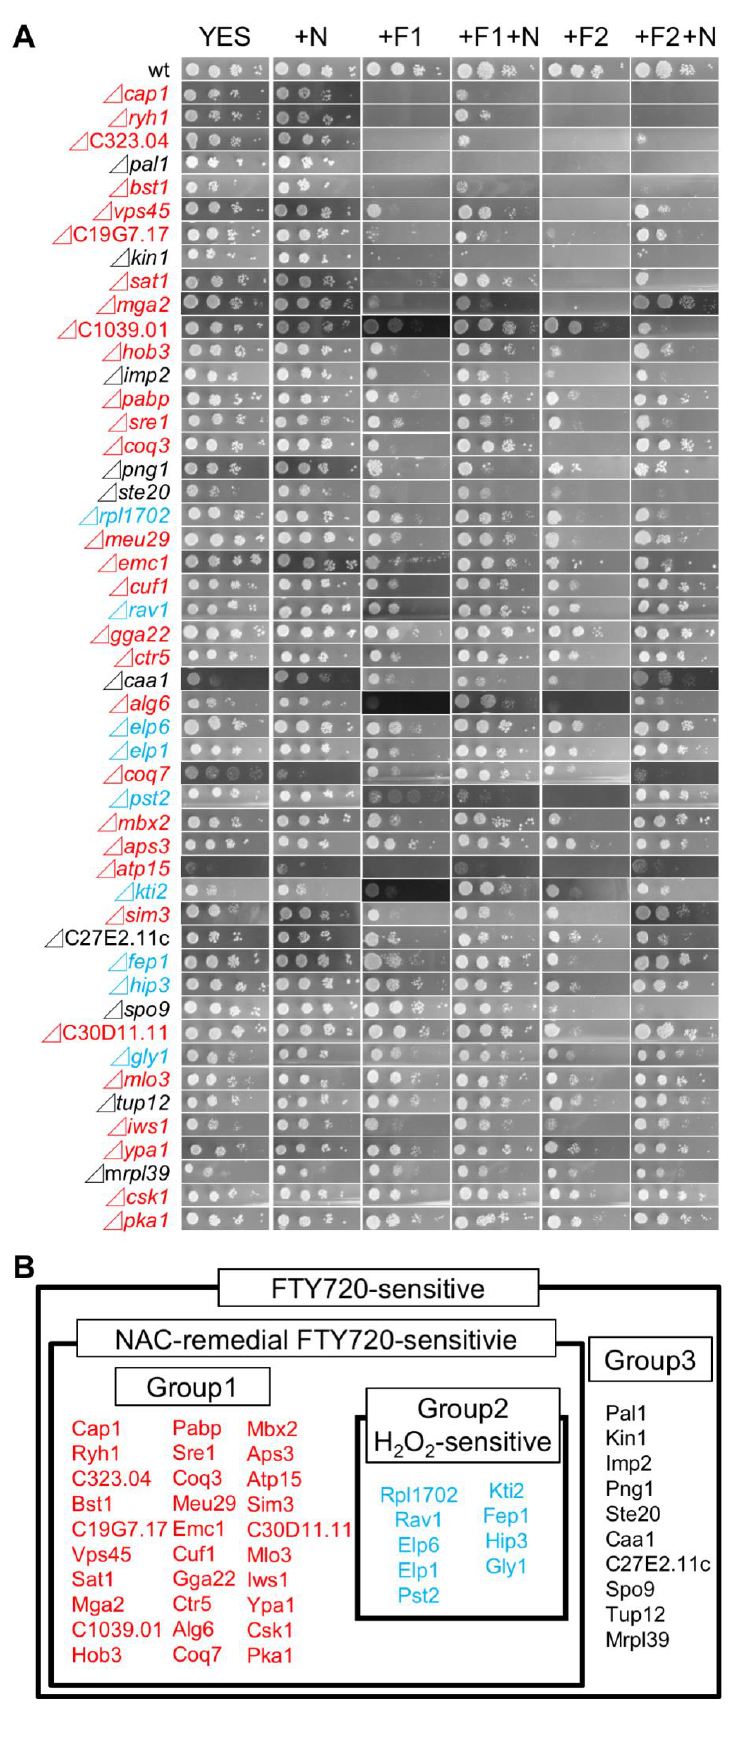
FIGURE 2: FTY720-sensitivity screening using dilu- tion-series spot assay for the 49 KO strains identi- fied in the third screen. (A) Raw data of chemical genomics screening on the YES plate with 0, 10, 20 μM FTY720 (YES, +F10, +F20) in the ab- sence/presence of 5 mM NAC (+N). The genes shown in red affected the cytotoxicity of FTY720 and the reversibility by NAC (Group1). The genes shown in blue had growth defects in H 2 O 2 sensitivi- ty (Group2). (B) Venn diagram showing the result of